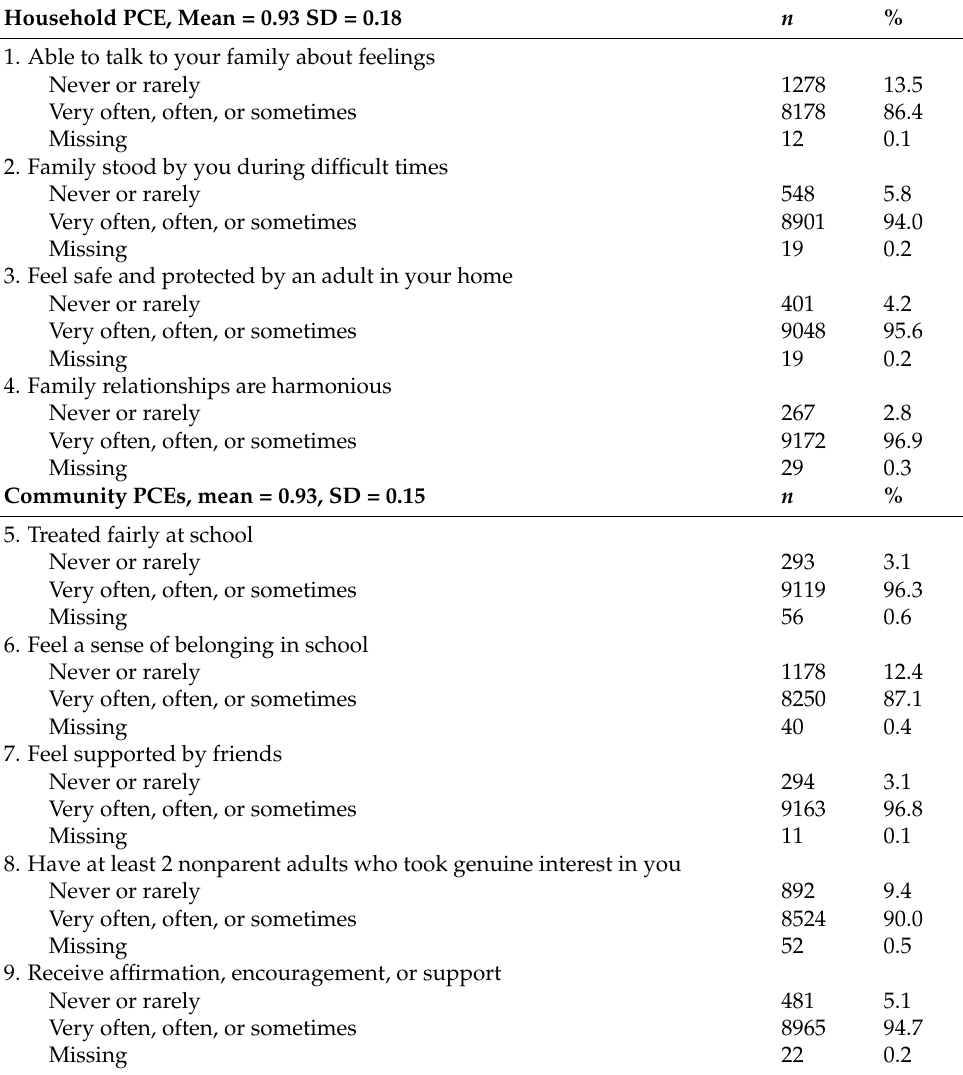
Table 2. PCEs exposures by